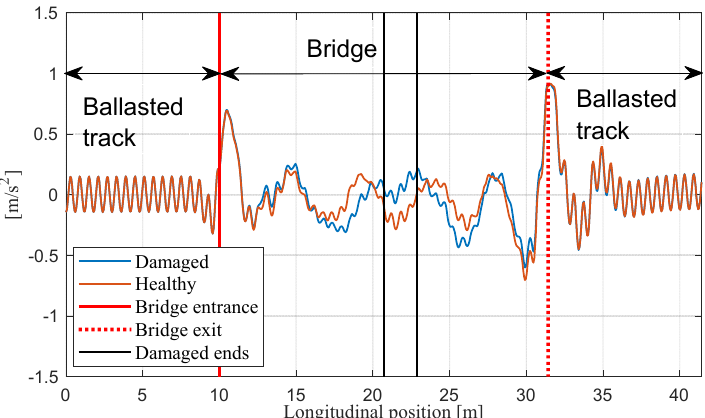
Figure 7. Leading bogie accelerations corresponding to the healthy and the damaged bridge. The CSA train travelling at 100 km/h, in the absence of irregularity and total damage affecting the side wall diagonal chord.